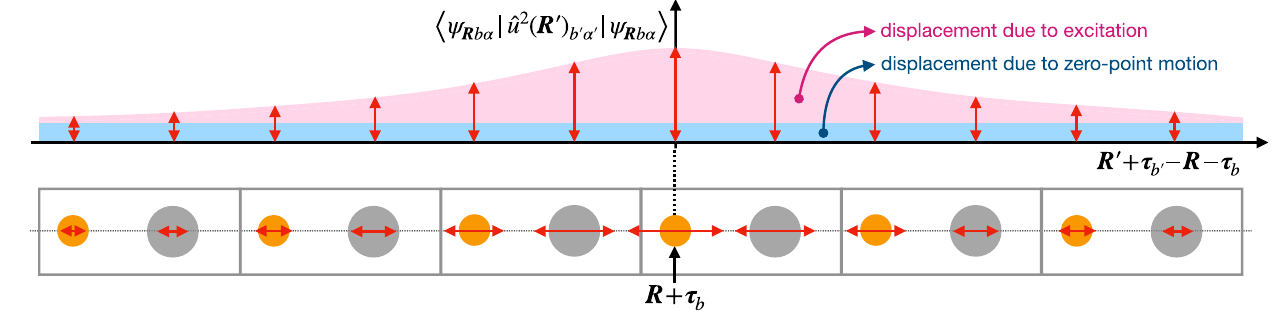
FIG. 1. ˆ a † ð R Þ b α applied to the ground state j 0 i creates an atomic vibration centered on the atom at position R þ τ b . The gray rectangles represent primitive cells of a lattice with basis, orange and gray circles symbolize atoms. The horizontal red lines show the mean square displacements (MSD) of the atoms. The vertical lines have the same length of the horizontal lines below them; they show that in the excited state j ψ R b α i ¼ ˆ a † ð R Þ b α j 0 i (where j 0 i is the ground state), atoms at position R 0 þ τ b 0 have a mean square displacement that becomes smaller as the distance j R þ τ b − R 0 − τ b 0 j increases. The envelope of the atomic MSD (vertical red lines) is decomposed into pink and blue, to emphasize that the total MSD in the excited state is the result of the sum of two terms: a space-dependent MSD due to the excitation created by ˆ a † ð R Þ b α (pink) and a space-independent MSD due to the zero-point motion (blue